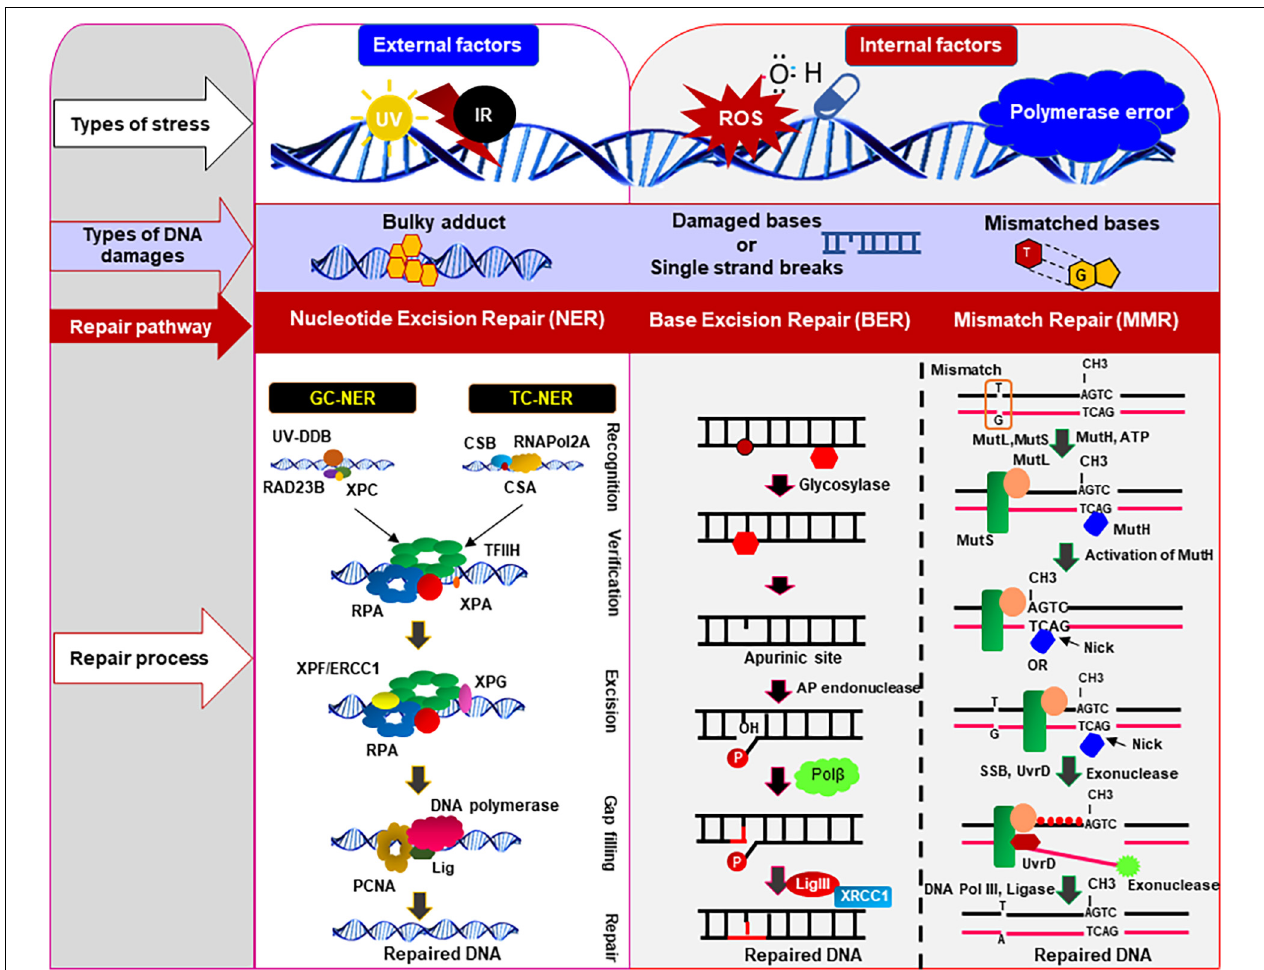
FIGURE 2 | DNA damages and repair pathways in mammalian cells. Various types of DNA damages/lesions are routinely induced in genomic DNA by both internal genotoxic agents (e.g., reactive oxygen species: ROS, DNA polymerase error) as well as by external agents (e.g., ultra-violet radiation, infrared radiation, etc.). These potentially lethal damages are efficiently repaired by specialized DNA repair pathways, depending on types of DNA damages and cell types. This figure illustrates the common and simplified graphical presentation of the different types of DNA repair pathways involved to resolve various types of damages/lesions in mammalian cells in an error-free way. The set of repair proteins may vary between different pathways, and there might be some overlapping steps in different repair pathways. Nucleotide excision repair (NER), base excision repair (BER), and mismatch repair (MMR) pathways are the main repair pathways that protect genome from the internal or external genotoxic agents. These repair pathways play important role in repairing damages that routinely occur in genomic DNA of the post-mitotic neurons to maintain the sequence integrity and health of neurons. CSA/CSB, cockayne syndrome protein A/B; ERCC1, excision-repair cross-complementing 1; TFIIH, transcription factor IIH; RPA, replication protein A; GG-NER, global genomic nucleotide excision repair; TC-NER, transcription-coupled nucleotide excision repair; Lig, DNA ligase; RNAPol2A, RNA polymerase subunit 2A; XPA/XPC/XPF/XPG, proteins involved in different xeroderma pigmentosum (XP); PCNA, proliferating cell nuclear antigen; Pol β , DNA polymerase β ; MLH, MutL protein homolog; MSH, MutS protein homolog; UV, ultraviolet; XRCC1, X-ray repair cross-complementing